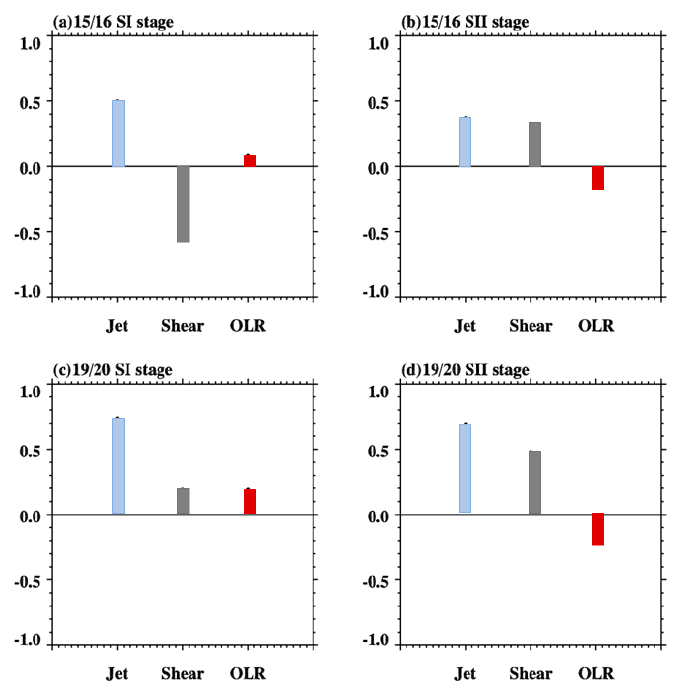
Figure 7. The standardized coefficients of the tropospheric jet (blue bars), stratospheric vertical shear (black bars), and tropospheric convection (red bars) during the ( a ) 2015/2016 SI stage, ( b ) 2015/2016 SII stage, ( c ) 2019/2020 SI stage, and ( d ) 2019/2020 SII stage.